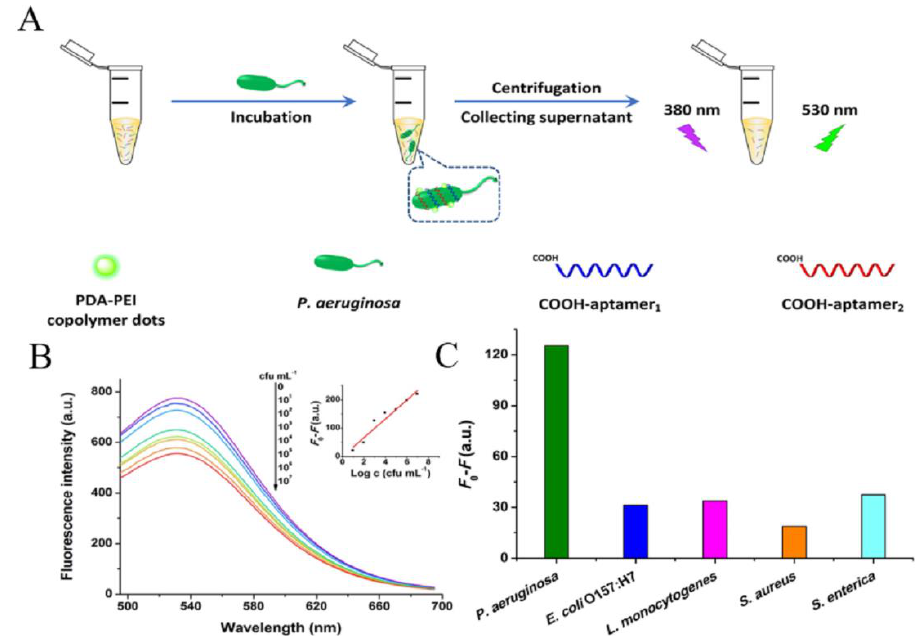
Figure 6. ( A ) Schematic of detection of P. aeruginosa . ( B ) FL with different concentrations of P. aeruginosa . ( C ) Change in FL with some bacteria [36]. Reprinted/adapted with permission from Ref. [36]. 2020, Elsevier.